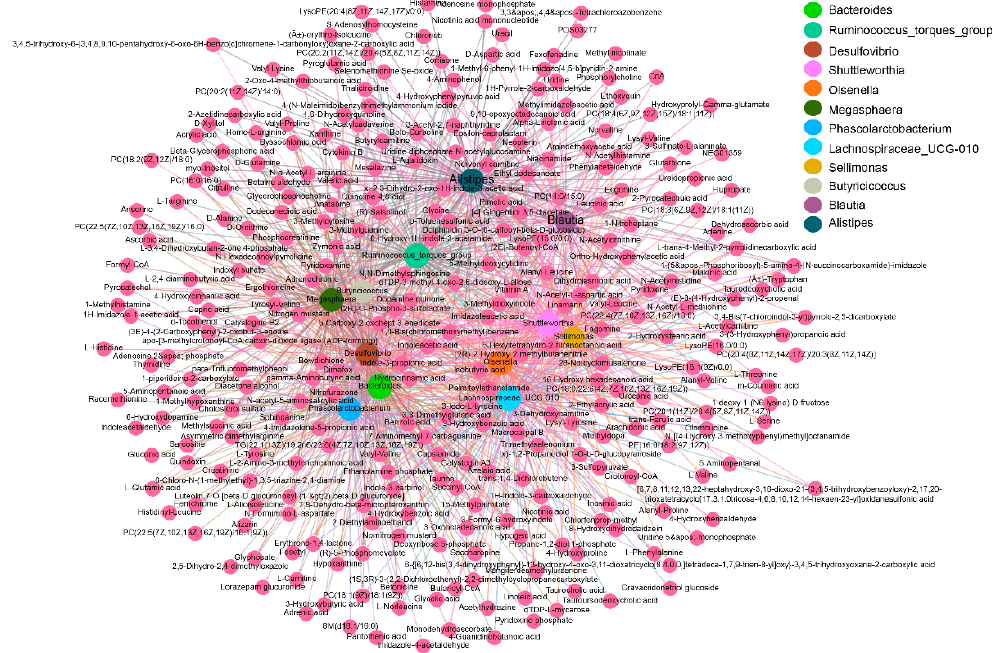
Figure 9. Correlation network between genera depleted by antibiotic treatment and differential metabolites. Different colours represent different genera. The wine-red nodes represent differential metabolites. NFD ( n = 4), NFDA ( n = 5).